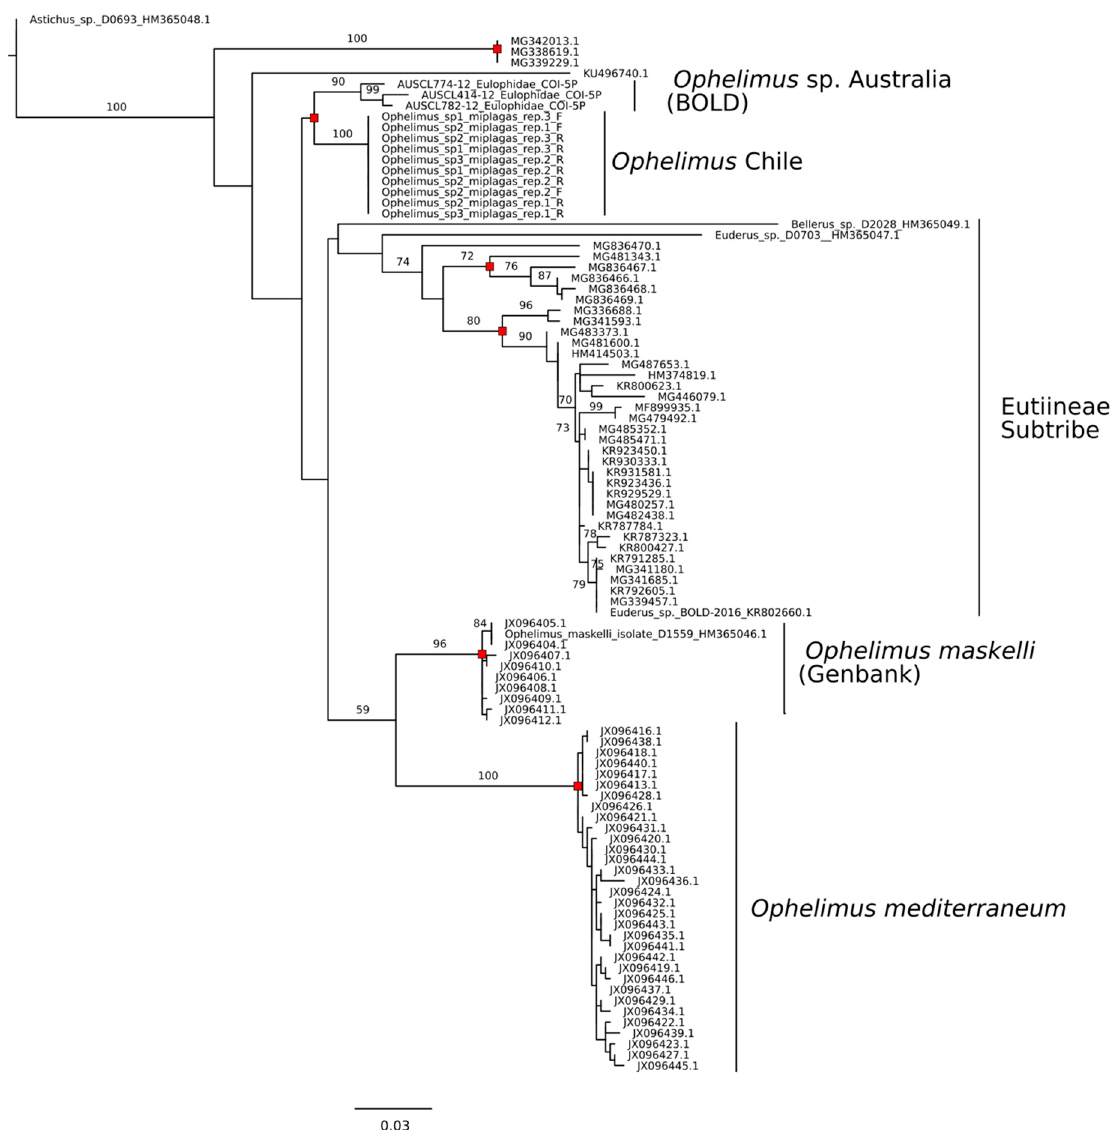
Figure 4. Maximum likelihood (ML) tree (log-likehood = − 3745.5244) from iqtree. Red squares represent proposed groups made by a multi-rate Poisson tree process (mPTP). Significant bootstrap values ( BP > 70) are shown above branches.